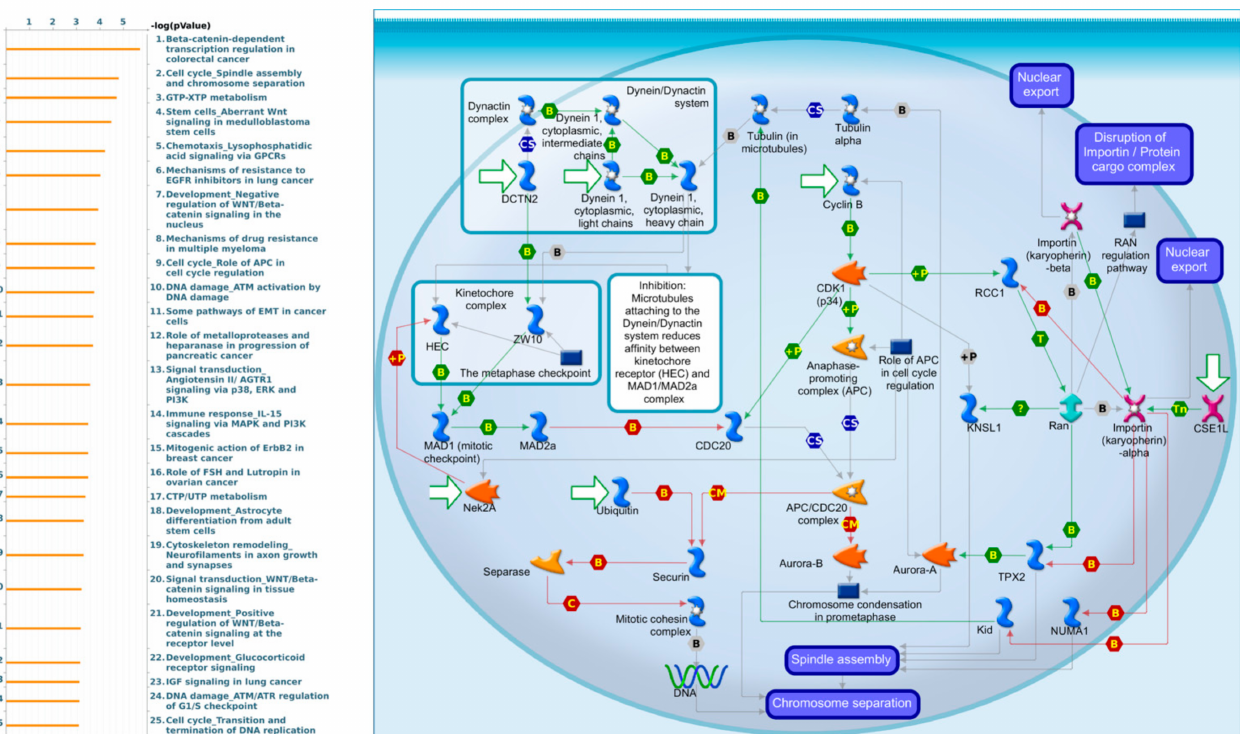
Figure 9. MetaCore enrichment pathway analysis of LSM4 co-expressed gene list in a breast cancer database. The approach was to collect the top 10% of expression gene lists from both METABRIC (2000 genes) and Pan-Cancer (1800 genes), then overlap them to produce a final genes list of 463 total genes. The pathway list was ordered by the -log [ p value] from the gene list extracted via TCGA Pan-Cancer atlas and METABRIC breast cancer patient databases. “Cell cycle Spindle assembly and chromosome separation” was at the top of the pathway list when performing the biological process